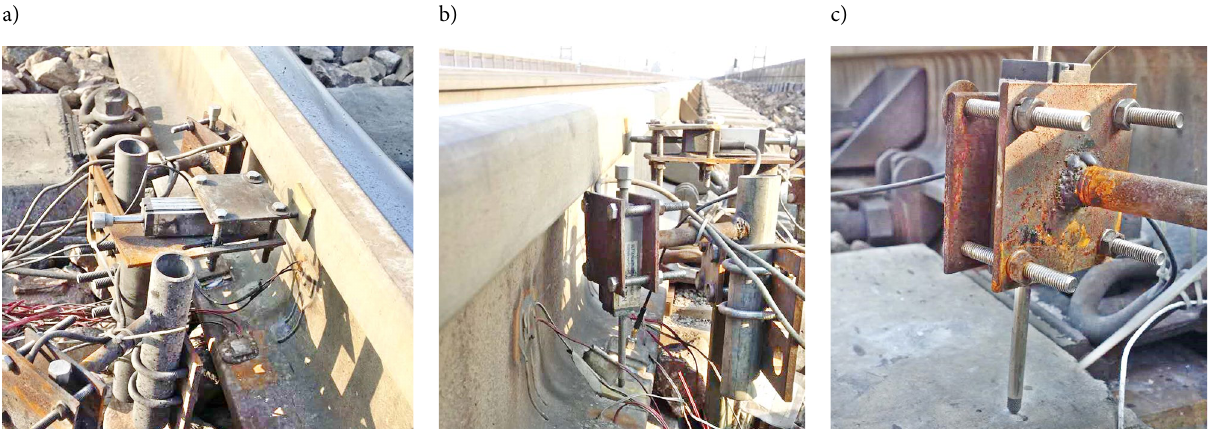
Figure 5. Arrangement of displacement sensors along: a – rail lateral direction; b – rail vertical direction;